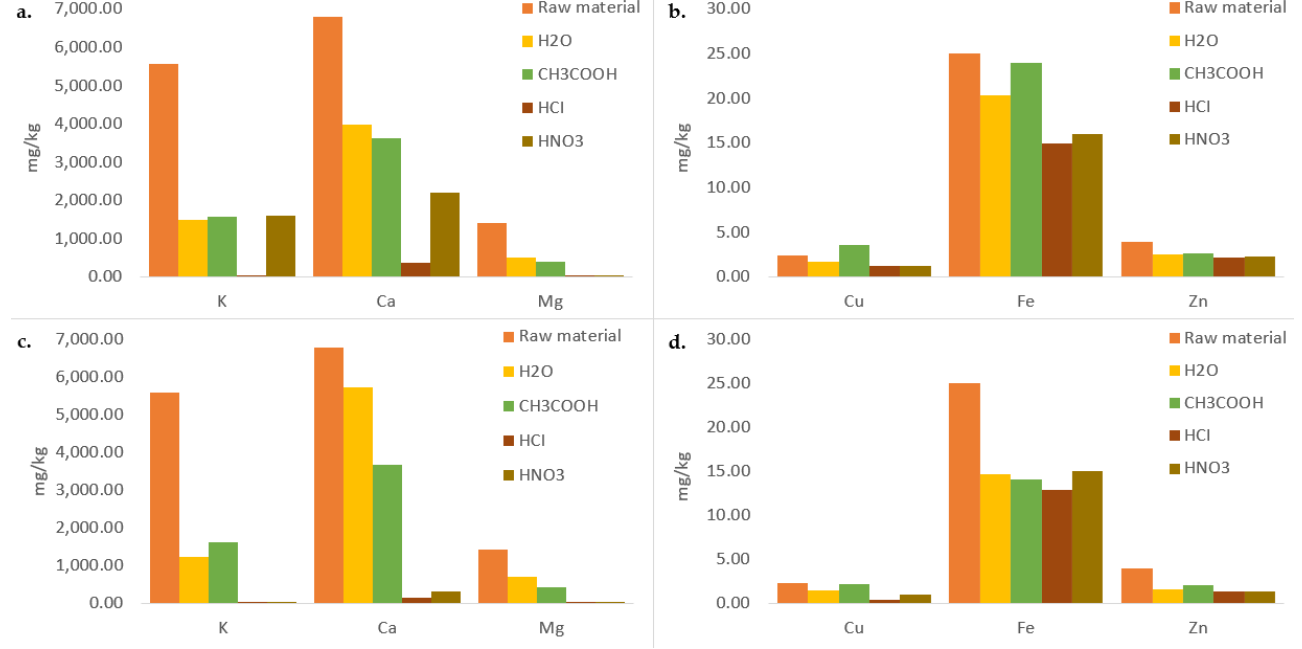
Figure 3. Atomic spectrometry analysis of: ( a ) macro elements in untreated and treated soybean I within 30 min ( b ) micro elements in untreated and treated soybean I within 30 min ( c ) macro elements in untreated and treated soybean I within 240 min ( d ) micro elements in untreated and treated soybean I within 240 min.